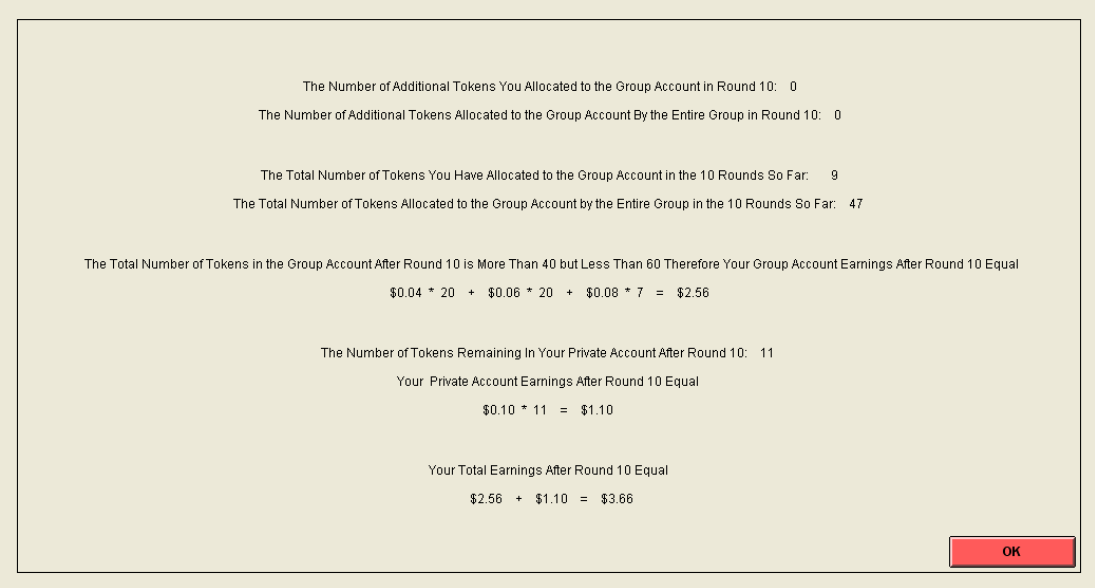
Figure A3. Output Screen.